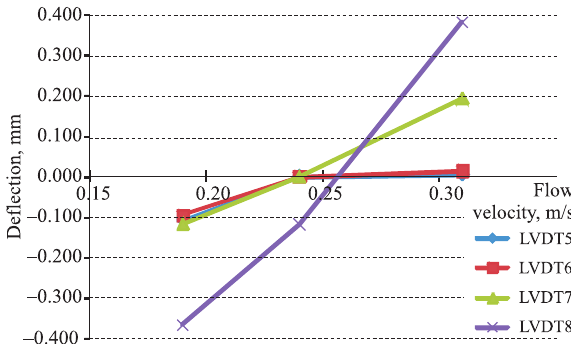
Fig. 19. Effect of flow velocity on pile deflection when the load at